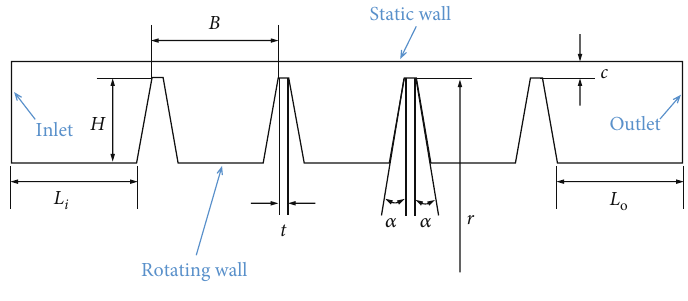
Figure 1: Geometric model.